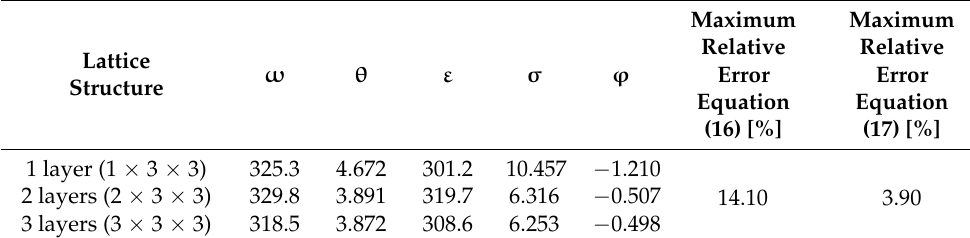
Table 6. Coefficients of the regression curves of Equations (16) and